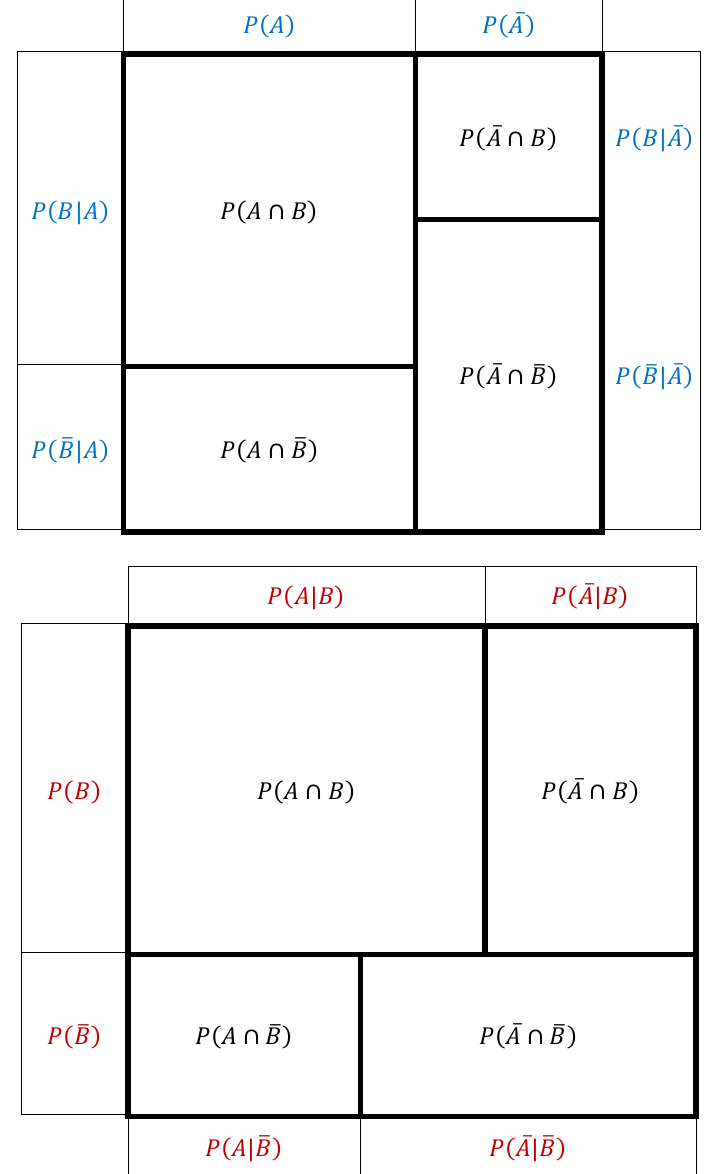
Figure 4. Modification of the Universe of Discourse of Figure 3 so as to be replaced by two different length/area-proportional Karnaugh-Map-like Diagrams. Each diagram is a liaison among the four conjunctive probabilities, two specific marginal probabilities and four specific conditional probabilities. Each map supplies four independent equations, each of which expresses a conjunctive probability (as a product of a conditional probability and a marginal one), as well as two additive relations for conditional probabilities. These twelve basic equations are supplemented by a thirteenth independent equation; which is one of the three equations